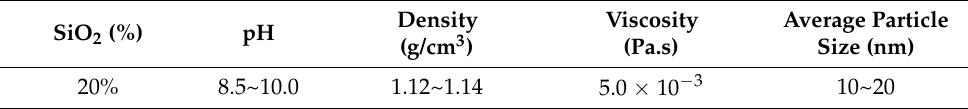
Table 2. Physical properties of the colloidal silica.